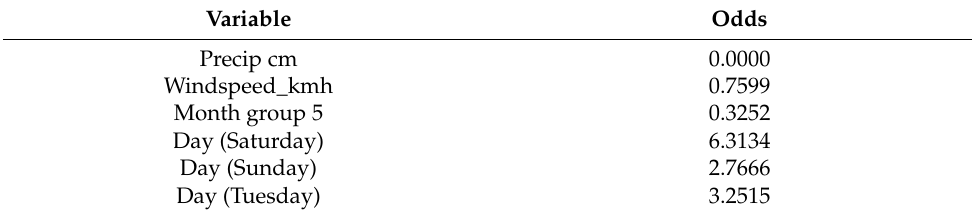
Table 5. Odds of the significant coefficients from the regression output. Variable Odds Precip